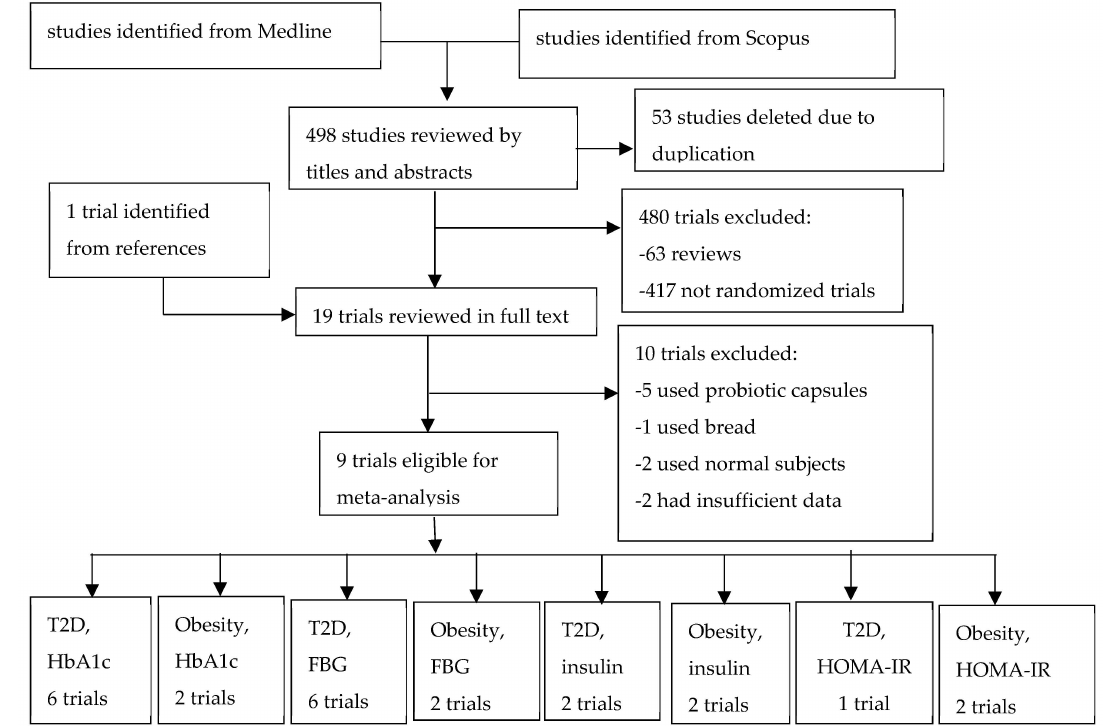
Figure 1. Flow chart of trial